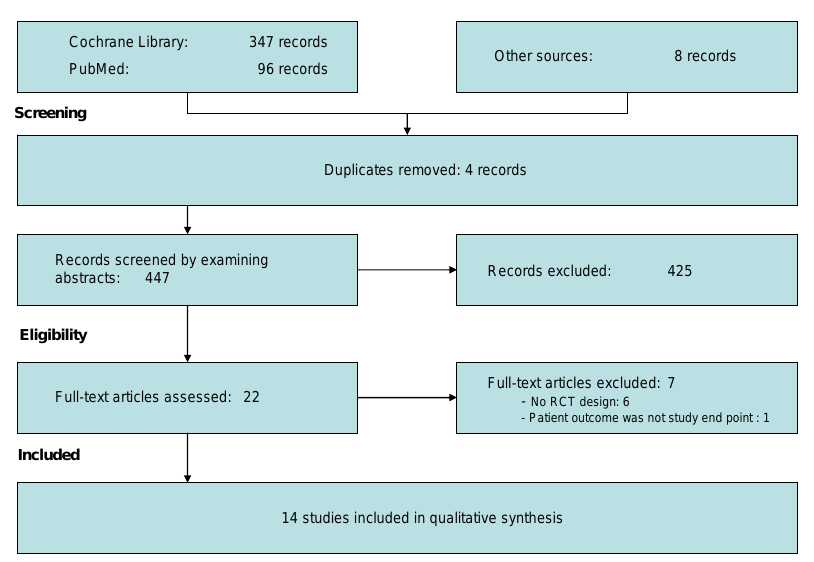
Flow diagram on phases of review process (according to PRISMA statement